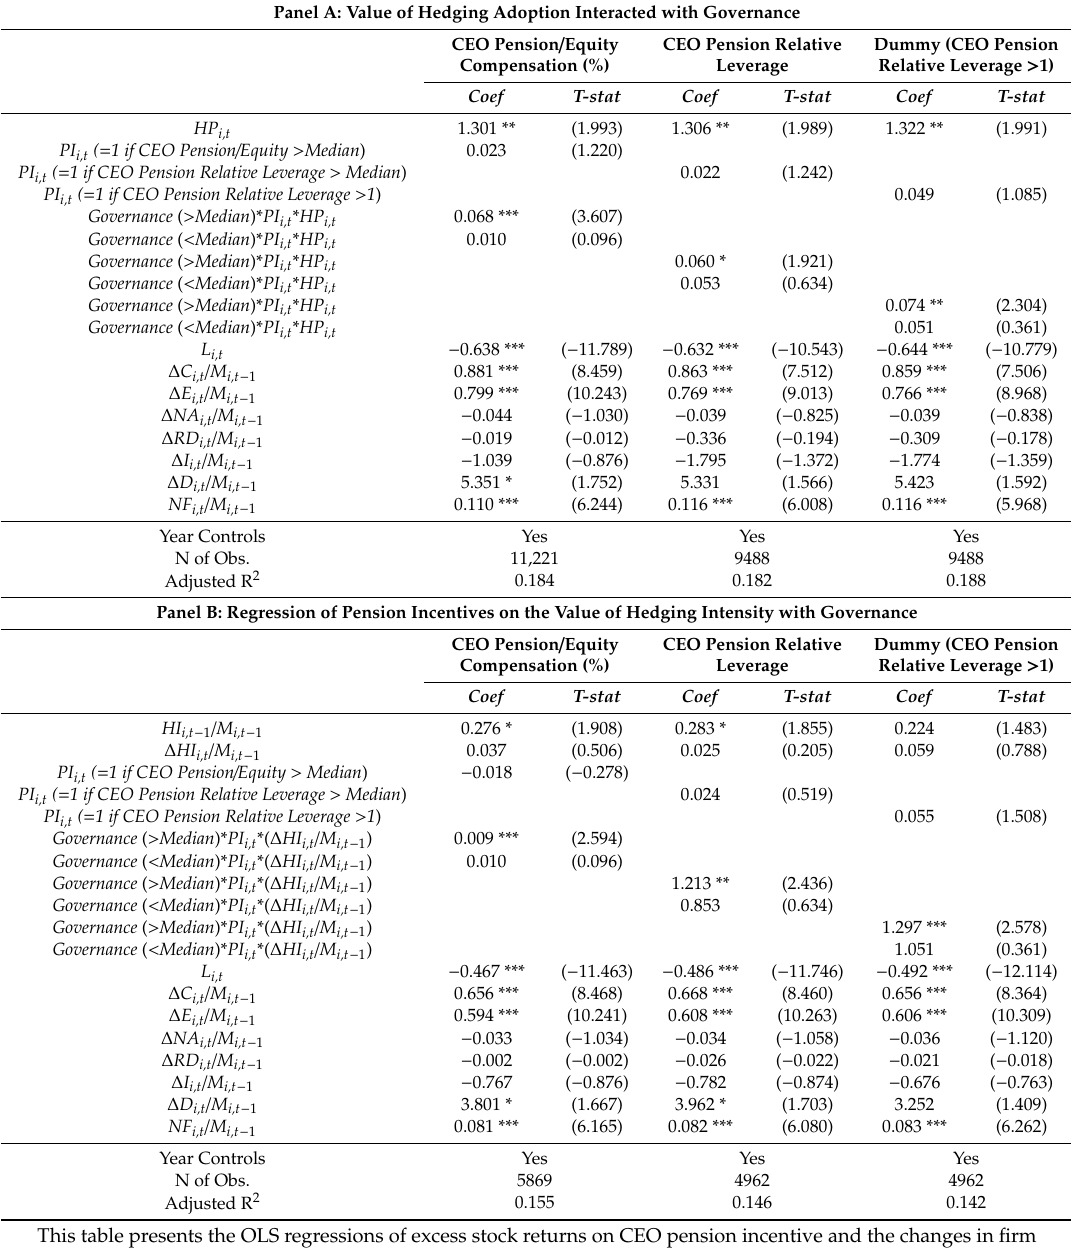
Table 9. The Value Creation of Pension Incentive through Hedging Interacted with Governance. Panel A: Value of Hedging Adoption Interacted with Governance CEO Pension / Equity Compensation (%)